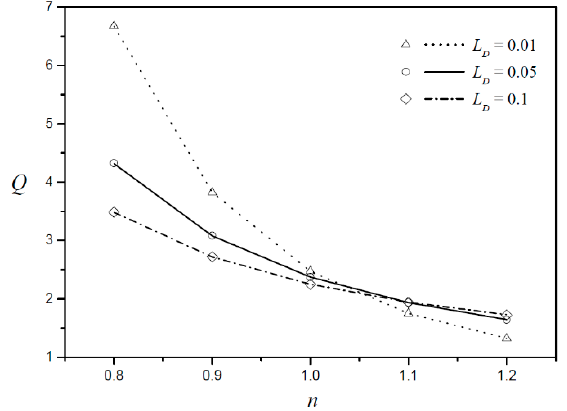
Figure 6. Velocity profiles according to the fluid behavior index with fixed zeta potential ratios ( Z R = 0.5) and Debye length ( L D = 0.05 ).